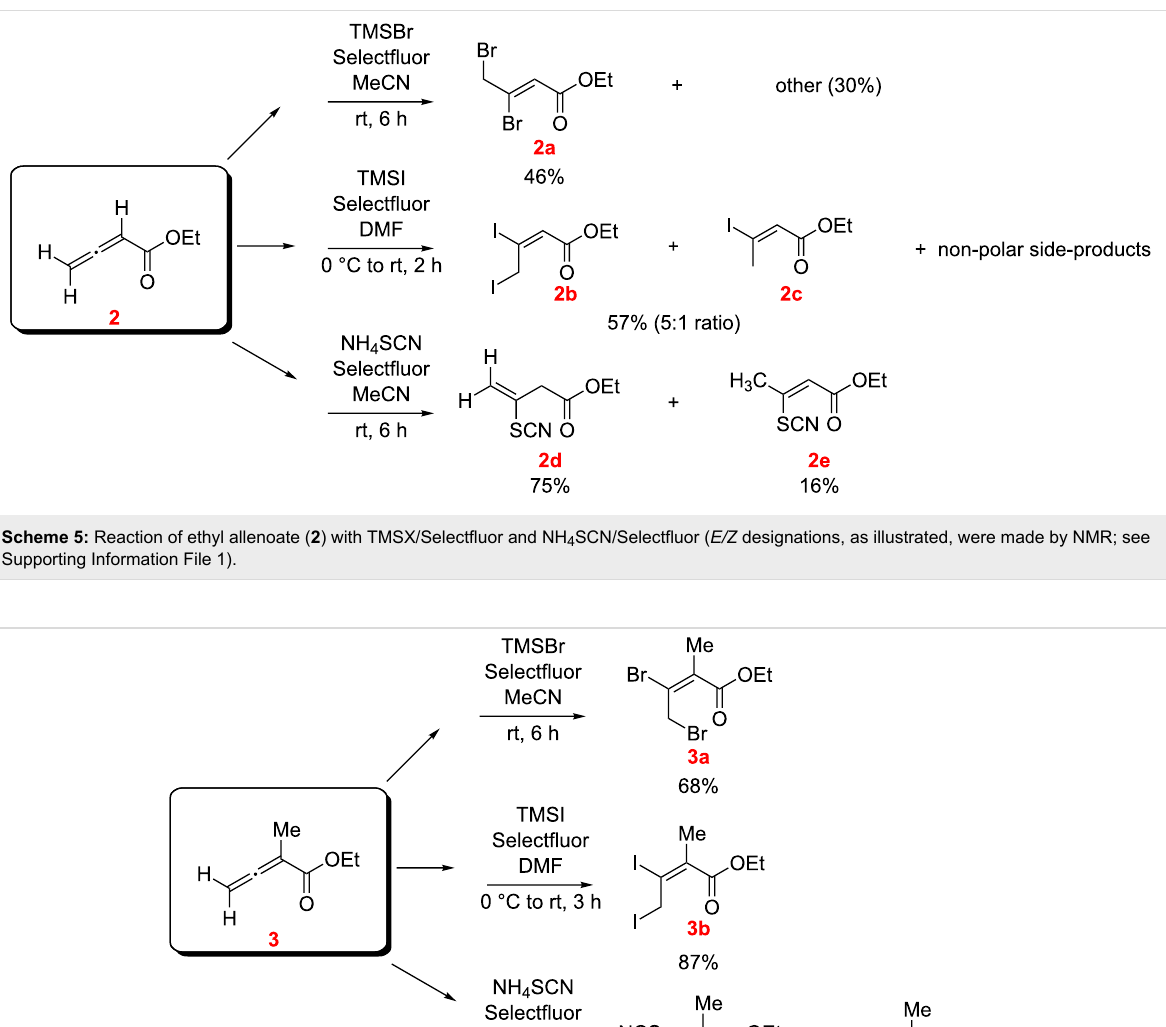
2c (accompanied by unidentified side products). With NH 4 SCN however only the conjugate addition products 2d and 2e were